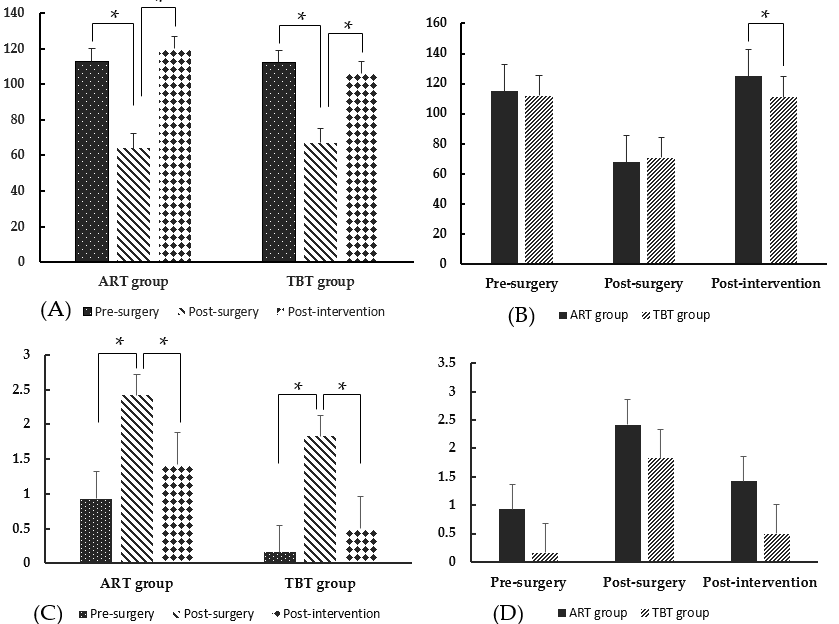
Figure 3. Comparison of ROM within and between groups. ( A ) Knee flexion within groups, ( B ) knee flexion between groups, ( C ) knee extension within groups, ( D ) knee extension between groups. * p < 0.05.